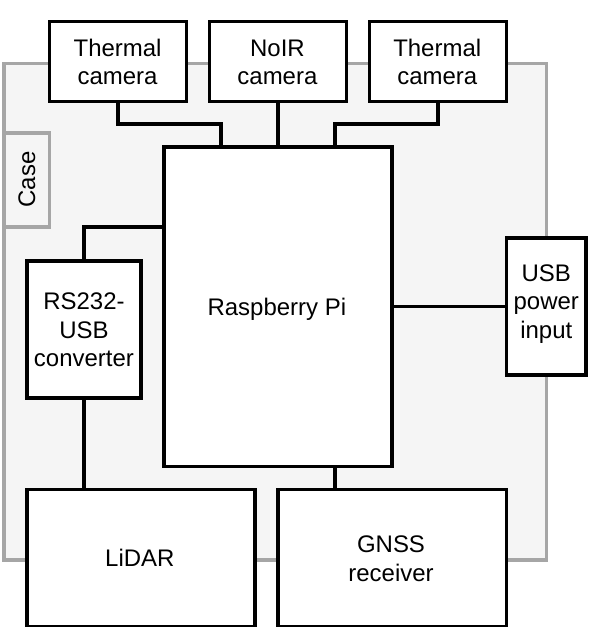
Figure 2. High-level scheme of the hardware module showing the connections between its components.